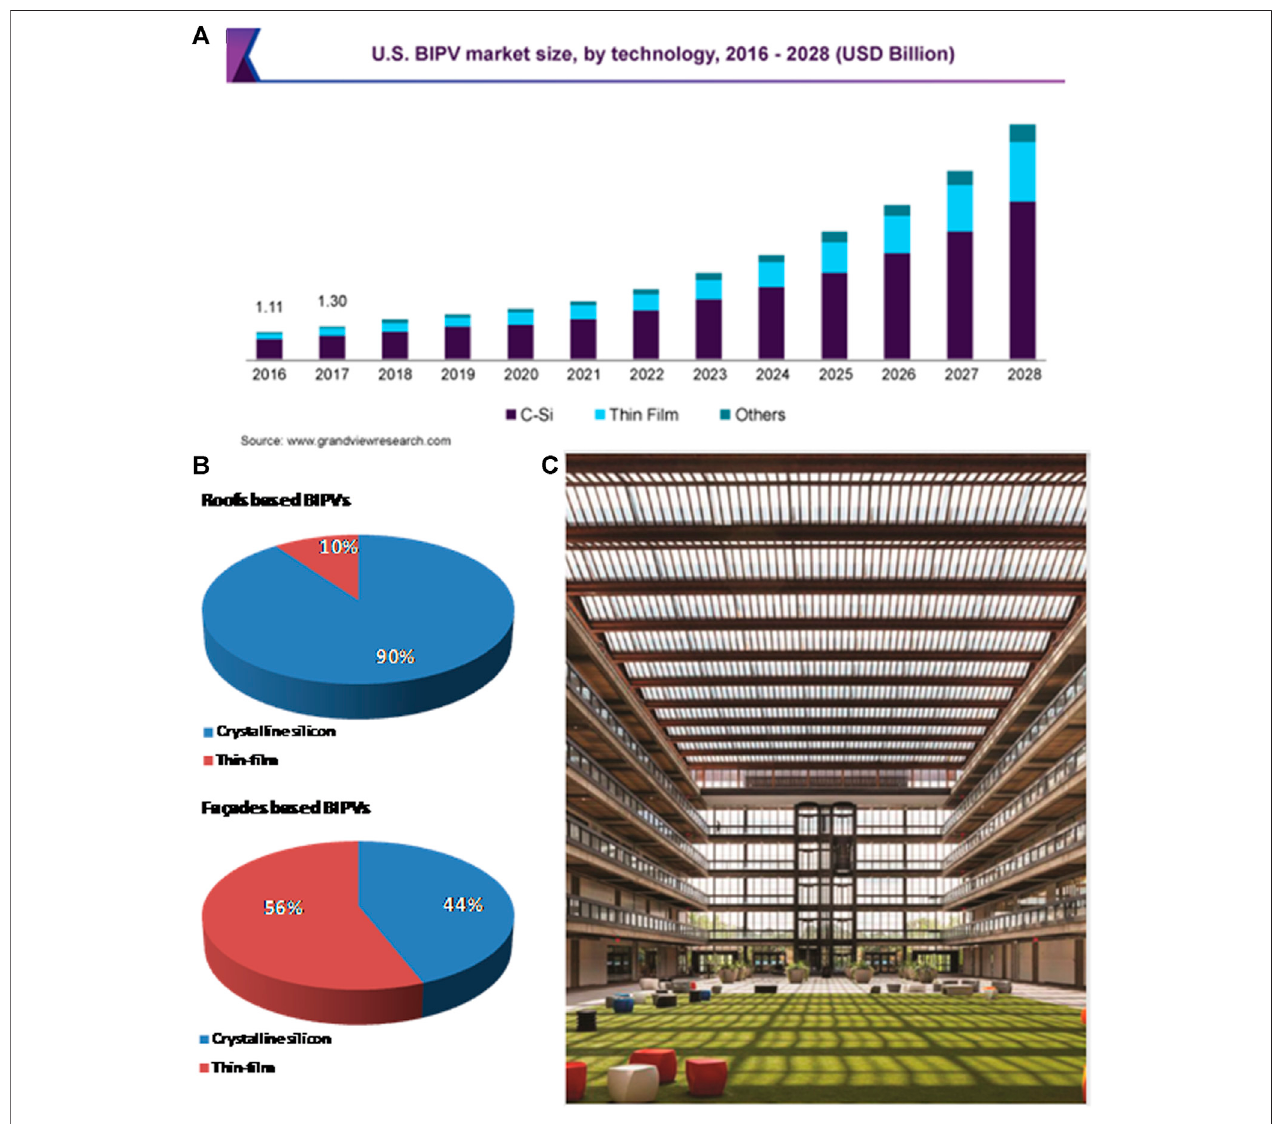
FIGURE 1 | (A) US forecast of BIPV market, © (2021) Grand View Research (EMR, 2021). (B) BIPV technologies split for (top) roof and (bottom) façade applications,respectively.Redrawnfrom(Zanettietal.,2017). (C) PhotographofsemitransparentBIPVsBellWorks,skylight,UnitedStates.Reprinted withpermission © Onyx Solar (Curti et al.,